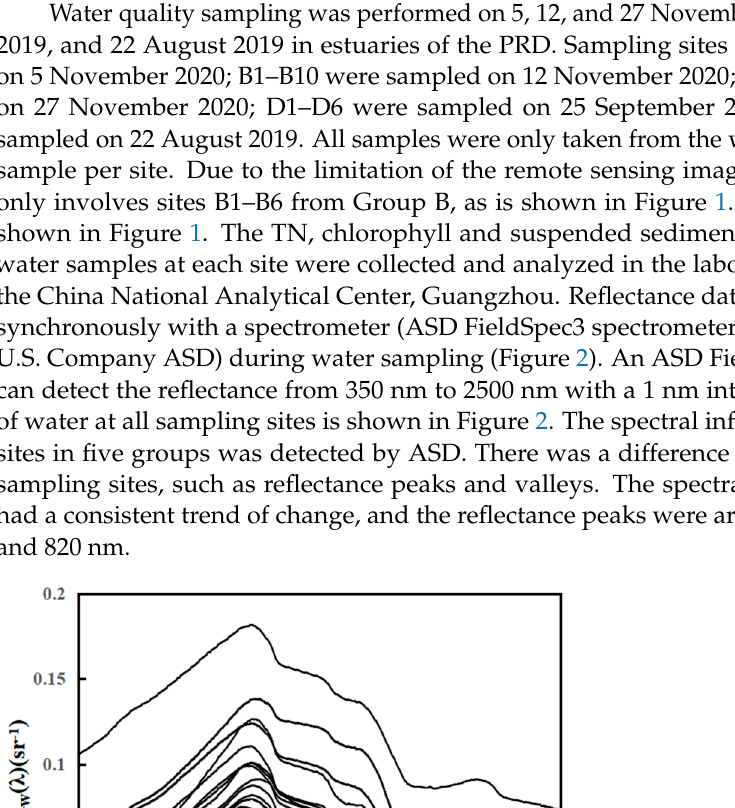
Table 1. Water quality analysis results of sampling sites. This table contains five sampling groups and their numbers. Each sampling group has statistical data of maximum, minimum, mean and median of material concentrations.